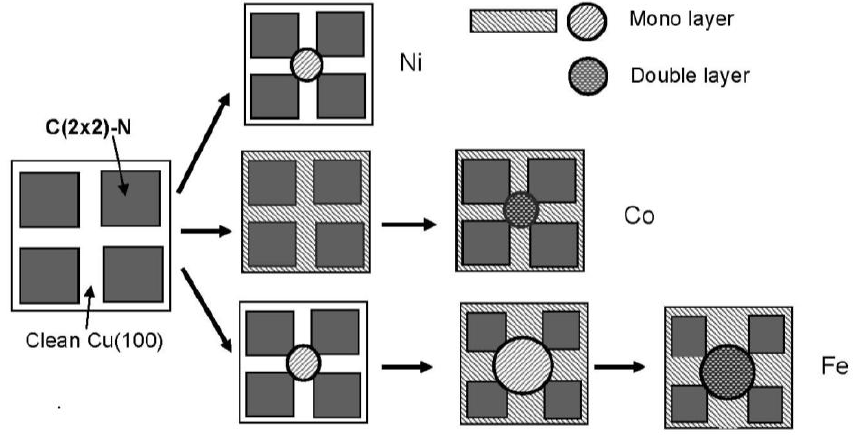
Figure 24. Models of kinetic controlled growth of Ni, Co and Fe nano-dots on the Cu(100) surface covered with c(2 × 2)-N square